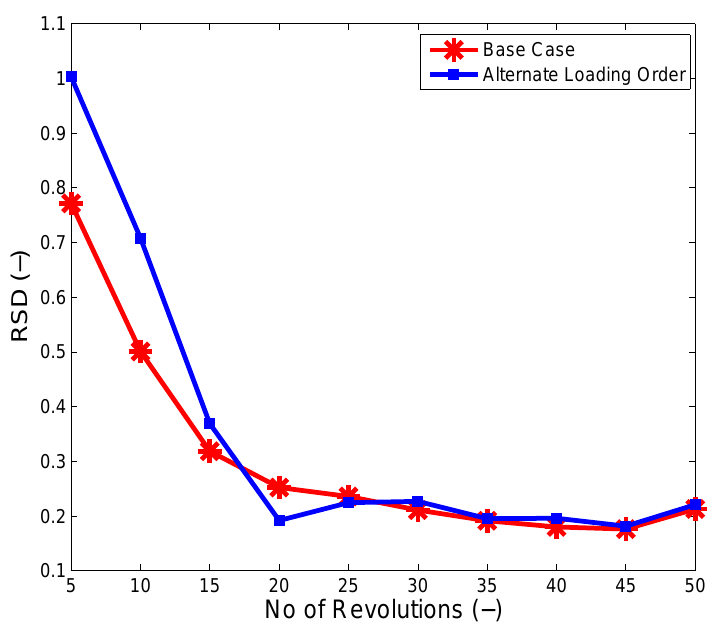
Figure 12. Variation of the RSD of API 1 with the change in loading